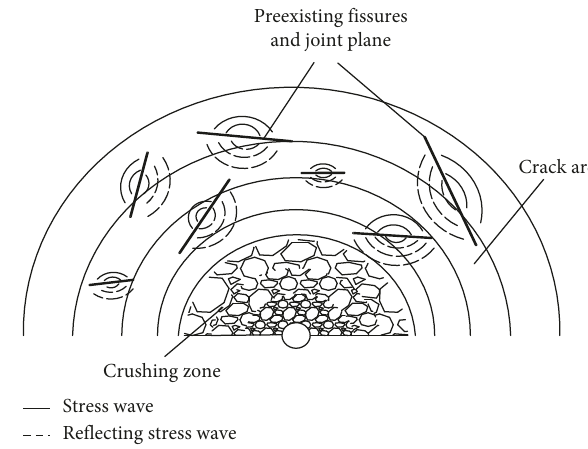
Figure 5: The effect of stress wave on